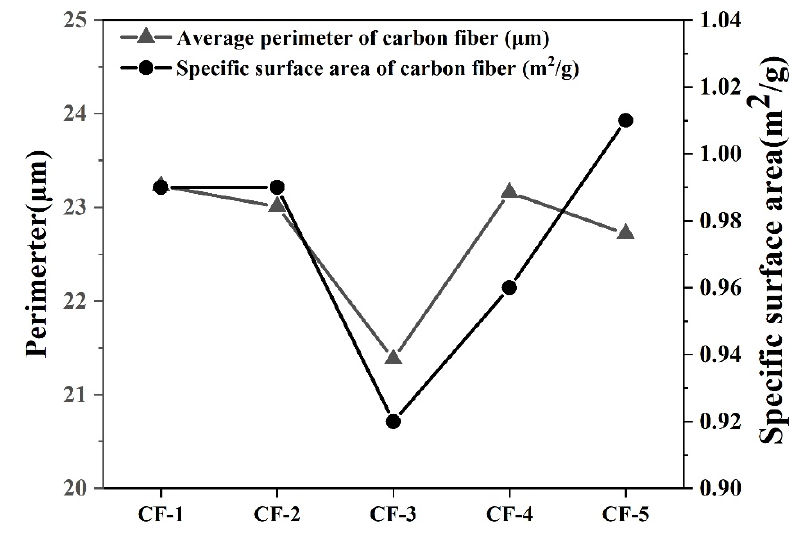
Figure 9. The relationship between specific surface area and perimeter of CFs.